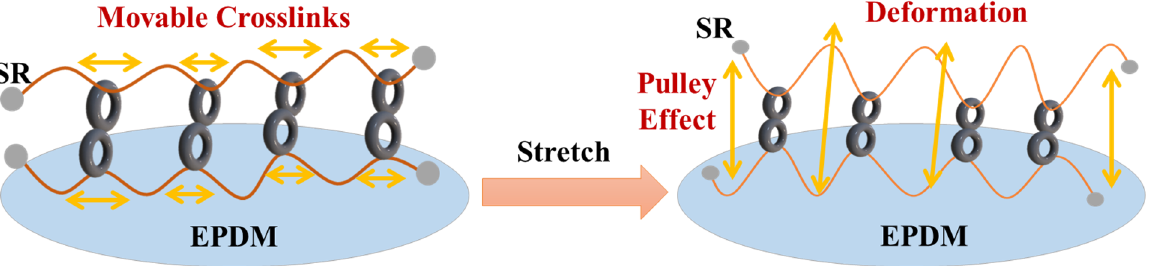
Figure 2. Schematics of ”Pulley effect” in slide-ring material-based composites before and after